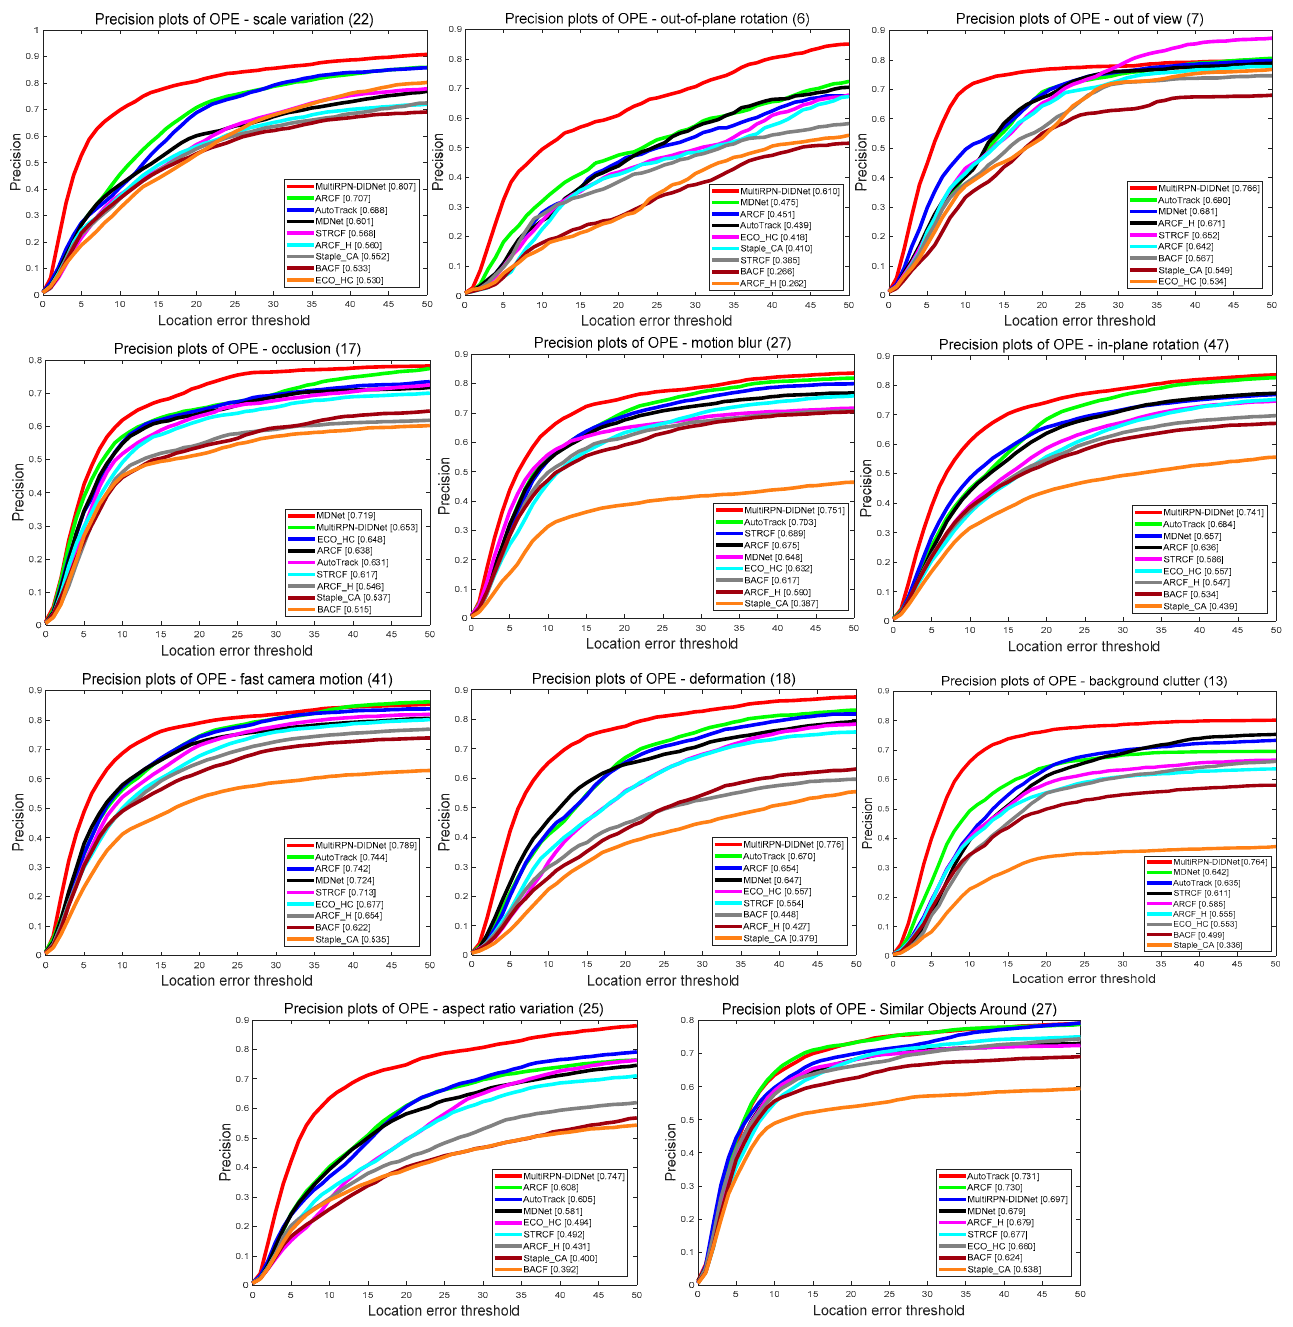
Figure 6. Precision comparison results of several state-of-the-art trackers on the DTB70 dataset. From left to right and top to down are the precision plots of SV, OPR, OV, OCC, MB, IPR, FCM, DEF, BC, ARV, and SOA video attributes.